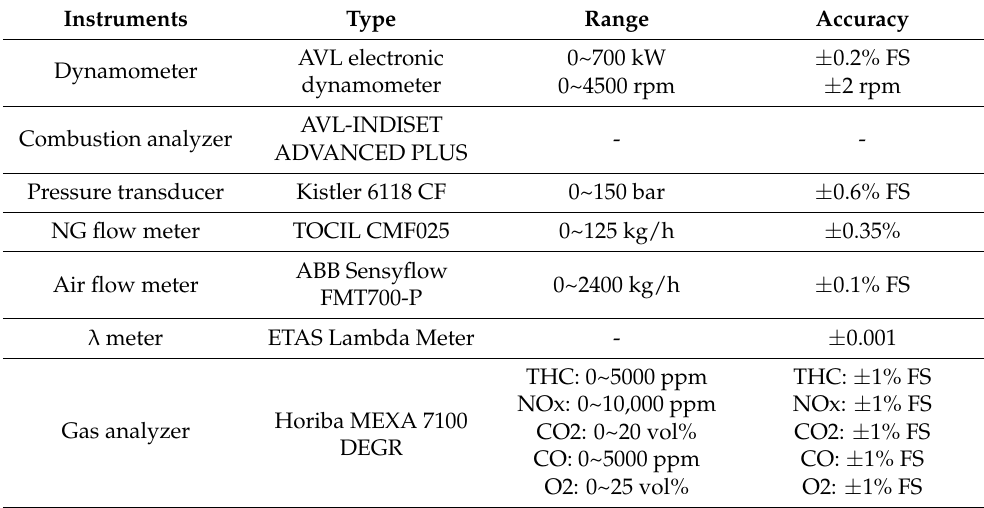
Table 3. The instruments for the bench